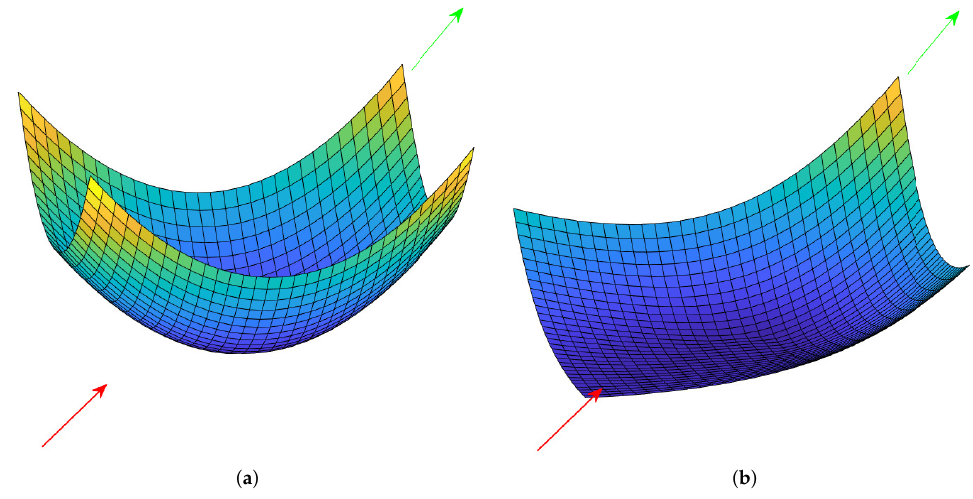
Figure 4. Comparison between APF and ADPF for an attractive potential field. ( a ) APF, ( b )